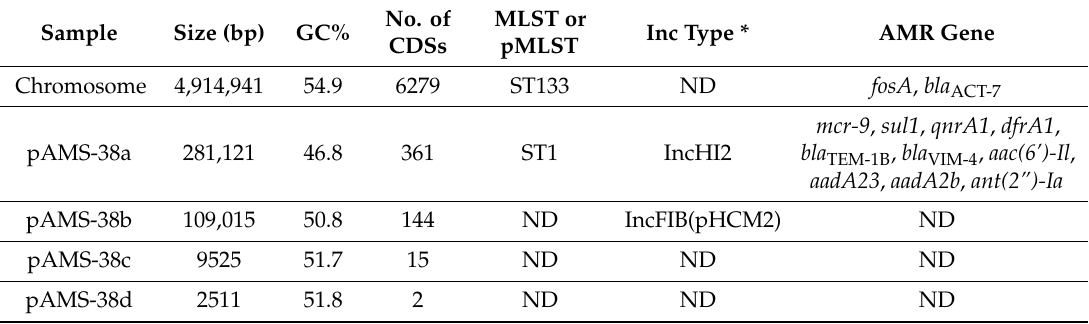
Table 1. Features of chromosome and the plasmids identified in E. hormaechei AMS-38 from